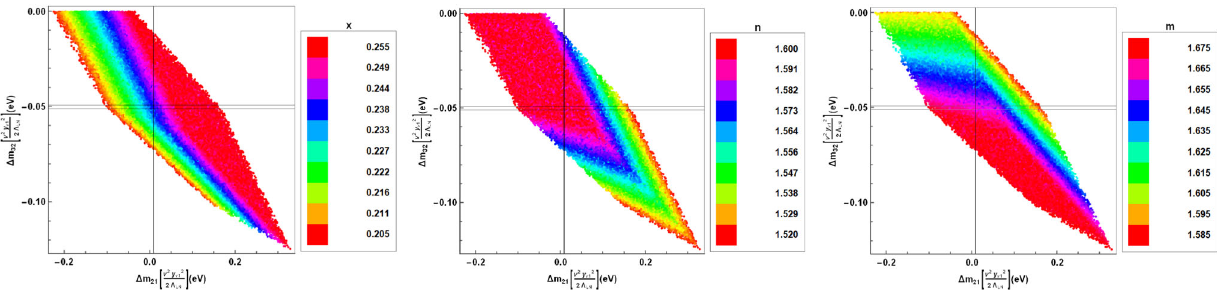
Fig. 6 Neutrino mass splittings resulting from the corrections induced by the second operator in Eq. (4.32). Each point in the plot represents a different set of random values for { x , n , m } . The 3 σ range for (cid:8) m 21